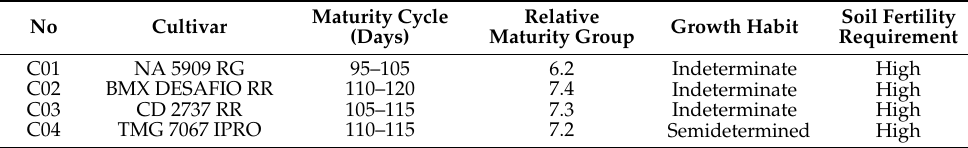
Table 2. Some characteristics of the four soybean cultivars used in this experiment. No